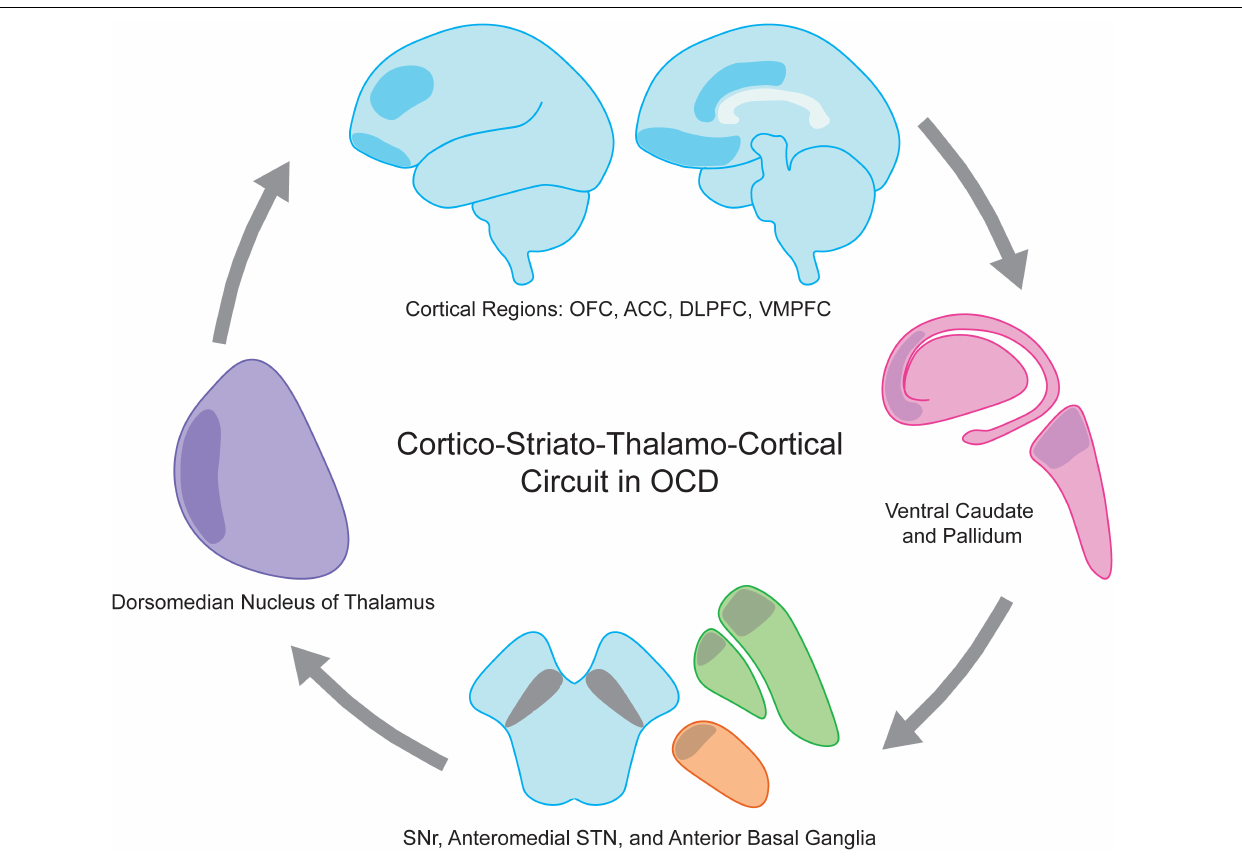
FIGURE 1 | Obsessive compulsive disorder (OCD) is a disease of the cortico-striato-thalamo-cortical circuit. Involved anatomic regions include executive and limbic cortical regions such as OFC, ACC, DLPFC, and VMPFC (shaded blue), ventral caudate and pallidum (shaded pink), anterior globus pallidus interna and externa (shaded green), anteriomedial STN (shaded orange), SNr, and dorsomedian nucleus of the thalamus (shaded purple). ACC, anterior cingulate cortex; DLPFC, dorsolateral prefrontal cortex; OFC, orbitofrontal cortex; SNr, substantia nigra pars reticulata; STN, subthalamic nucleus; VMPFC, ventromedial prefrontal